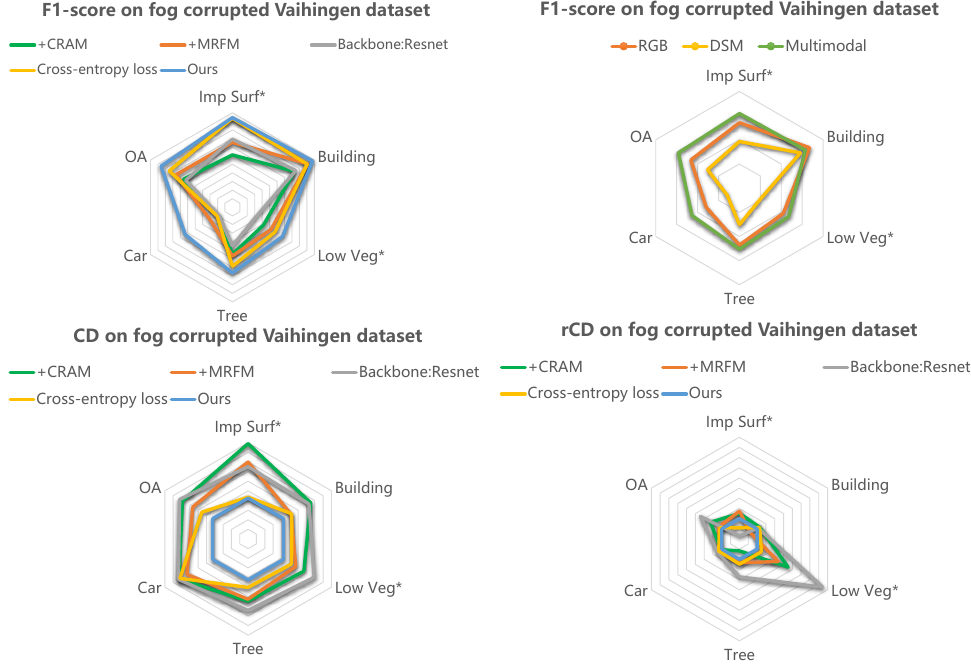
Figure 8. Radar plot visualization of the ablation study results. The first in top two is the classification result when different modules are integrated into the backbone. The second is about different inputs. Based on the radar plots regarding CD and rCD , the smaller envelope range is indicative of a model that is more robust on a fog-corrupted test set.